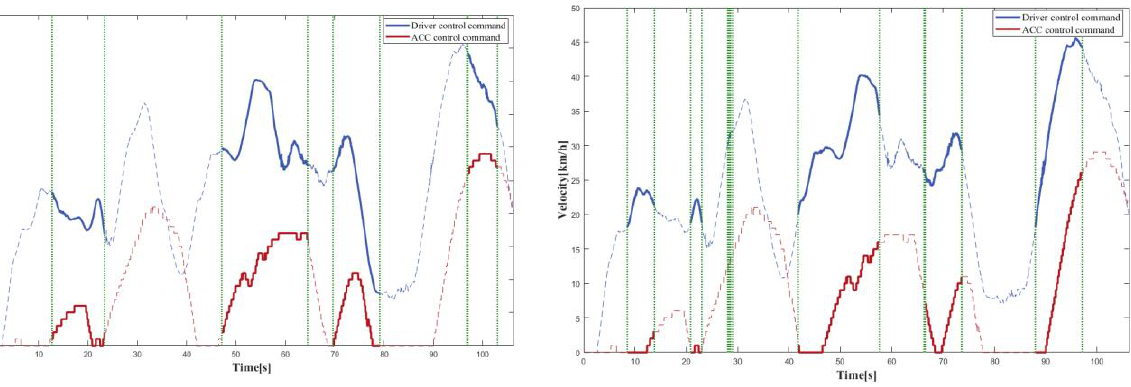
( b ). Trigger based on the instantaneous discrepancy value. Figure 11. The 1st round test results for longitudinal control command discrepancy data trigger recording.